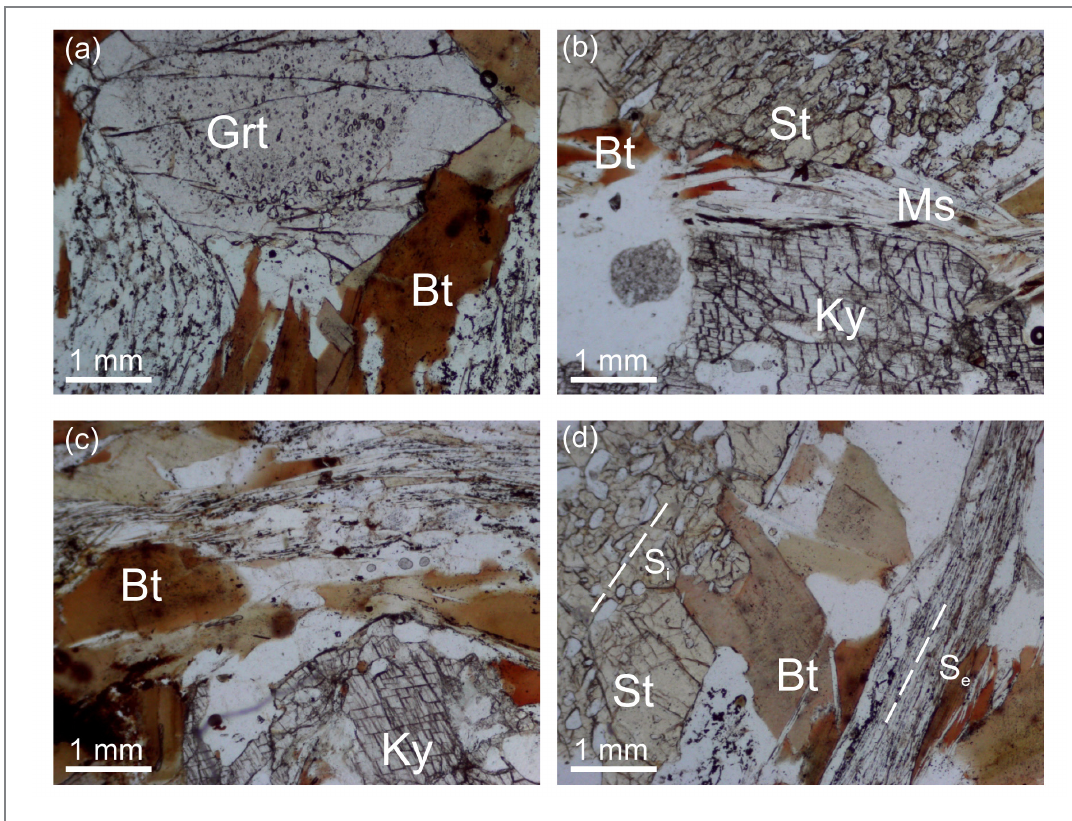
Figure 4 - Metamorphic aspects of the study area. a) Zoned garnet (Grt) porphyroblast. (b) Metamorphic assemblage biotite (Bt)-muscovite (Ms)-kyanite (Ky)-staurolite (St). (c) Elongate porphyroblast of kyanite parallel to the foliation defined by biotite. (d) Elongate poikiloblast of staurolite with internal foliation (Si) parallel to the external foliation S2